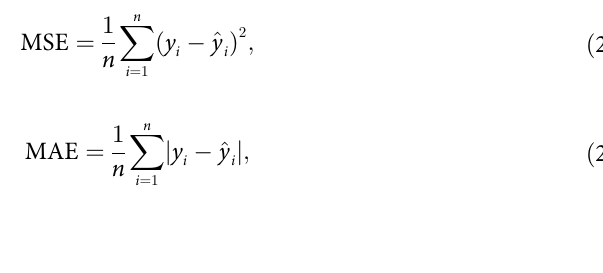
quality for five datasets. The missing data are processed by the linear interpolation method.